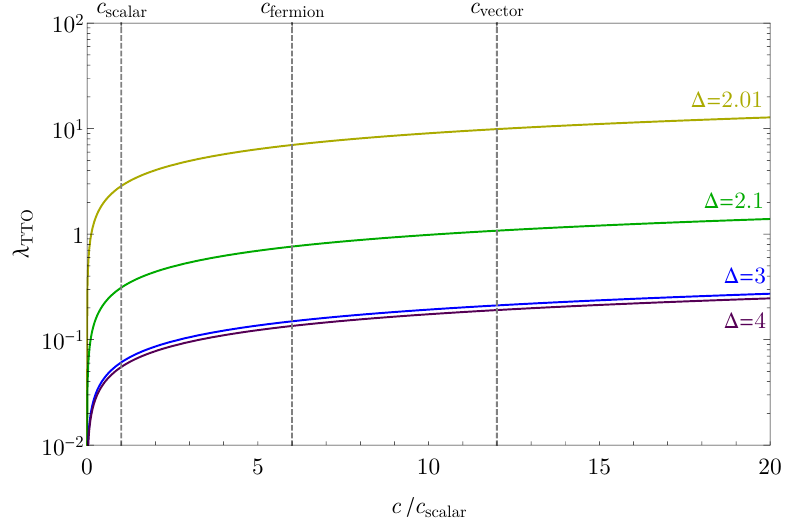
Figure 3 . Upper bound on the size of the OPE coe(cid:14)cient for a scalar operator of dimension (cid:1) entering the T (cid:2) T OPE, for a given value of the c anomaly. The bound is weaker for operators of dimension close to 2. This can be alternatively be understood as a lower bound on c for a (cid:12)xed value of the OPE